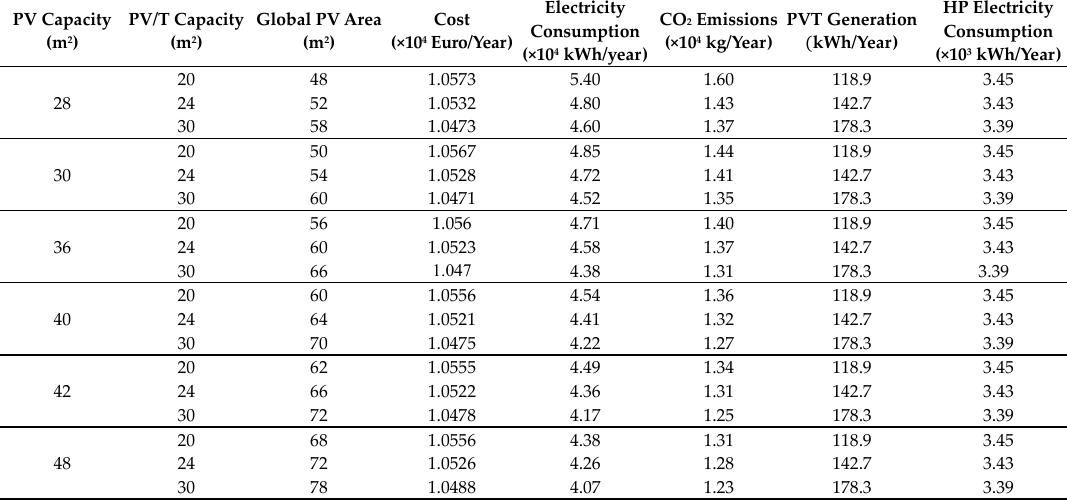
Table 6. Energy hub Performance of different PV and PV/T